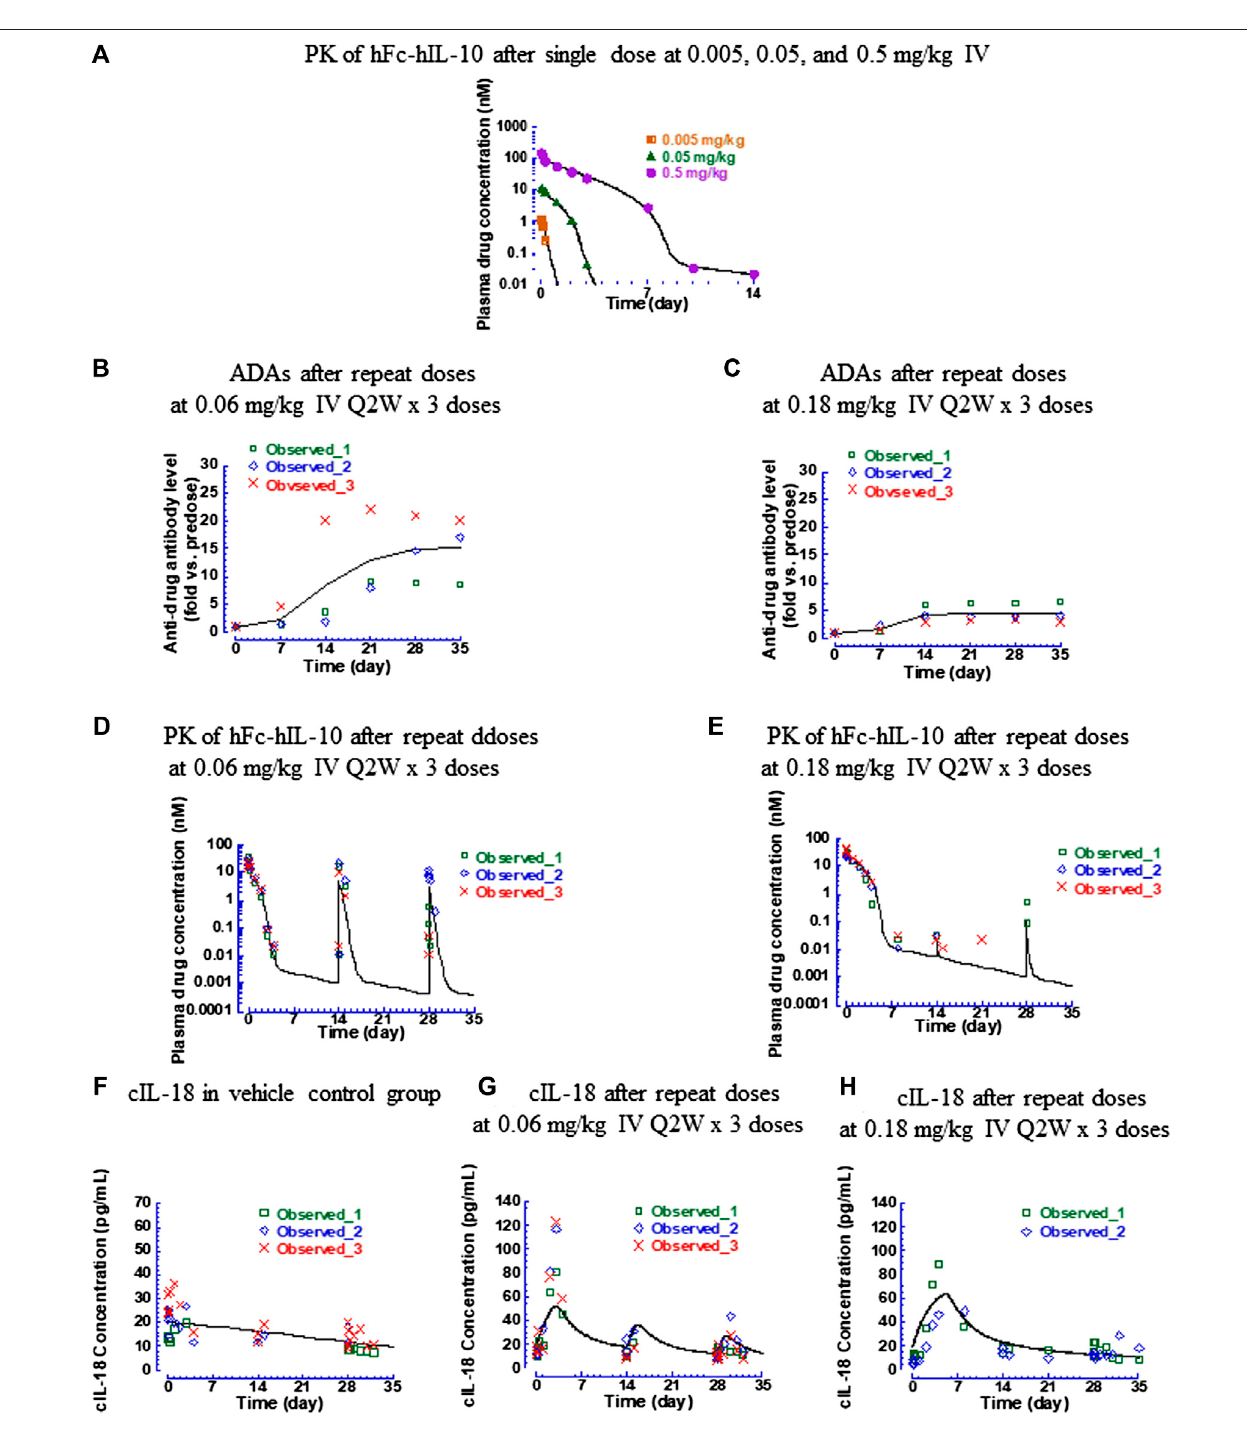
FIGURE5| Pharmacokinetic,antidrugantibody,andIL-18inductiondataofhFc-hIL-10incynomolgusmonkeys. (A) Fittedversusobservedpharmacokineticdata aftersingleintravenousdosesof0.005,0.05,and0.5 mg/kg; (B,C) Timecourseofantidrugantibodylevelsafterrepeatintravenousdoses(0.06and0.18 mg/kgQ2Wx 3 doses); (D,E) Fitted versusobservedpharmacokinetic dataafter repeat intravenous doses (0.06 and 0.18 mg/kg Q2W x3doses); (F – H) Fittedversusobserved IL-18 induction data after repeat intravenous doses (0.06 and 0.18 mg/kg Q2W x 3 doses). At 0.18 mg/kg, the IL-18 data of one monkey were not included in the data analysis and not shown in the fi gure, because of a much higher predose baseline than the rest of the animals. Lines represent the model- fi tted curves except for the antidrugantibodydatawherethelineisthemeanvalueofthegroup;symbolsshowindividualobserveddata( n =1pertimepointforthesingledose; n =3pertimepoint for repeat doses). When data points are less than the number indicated, they are below the lower limit of quantitation for pharmacokinetic data or unavailable for cynomolgus monkey IL-18 data.